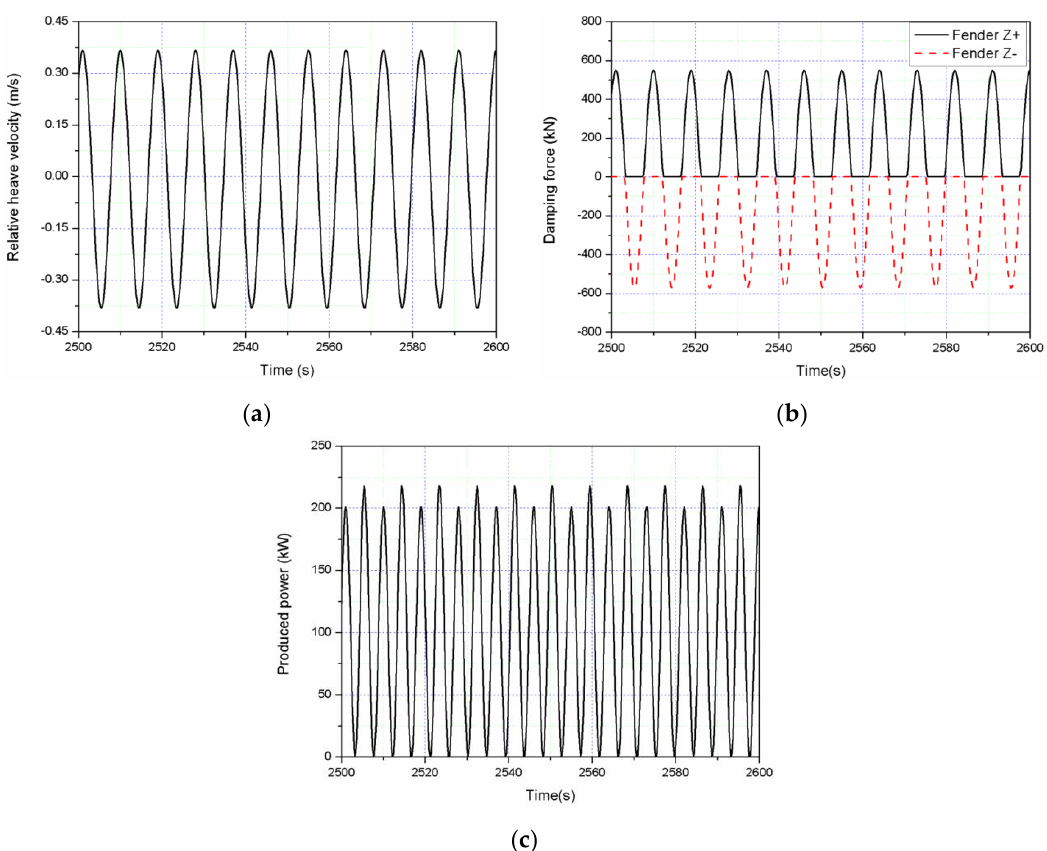
Figure 10. Time series of different responses of the combined structure under regular waves H = 2 m and T = 9 s: ( a ) relative heave velocity; ( b ) damping force; ( c ) produced power.